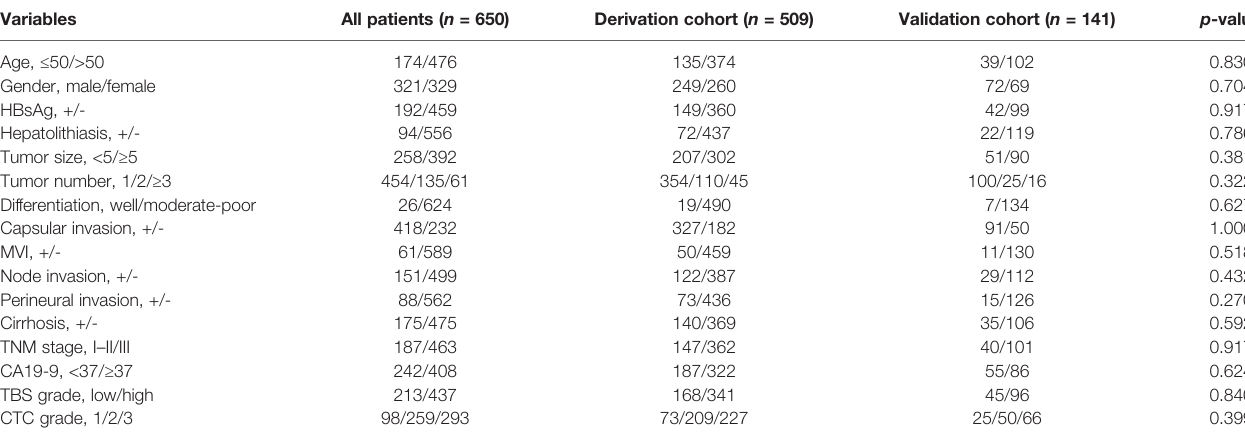
TABLE 1 | Baseline characteristics of 650 ICC patients who underwent curative